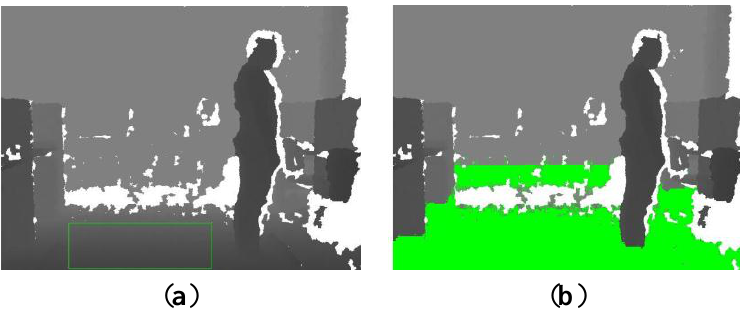
Figure 5. Extracted results of floor plane from depth images. ( a ) Definite domain of floor plane; ( b ) estimated results of floor plane.